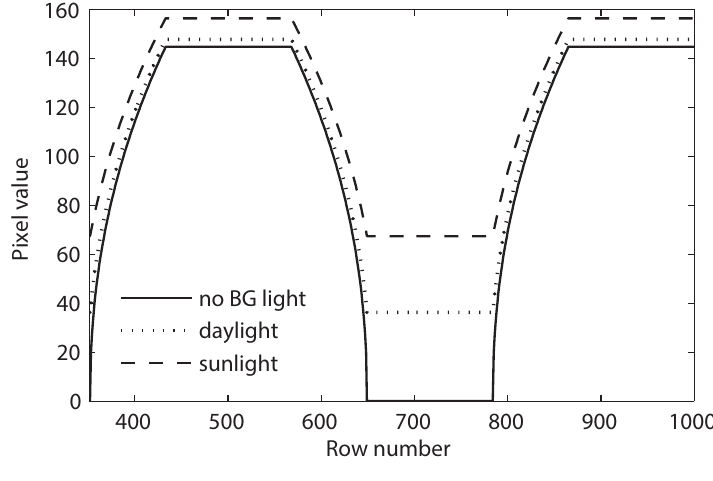
Figure 7. Effect of ambient